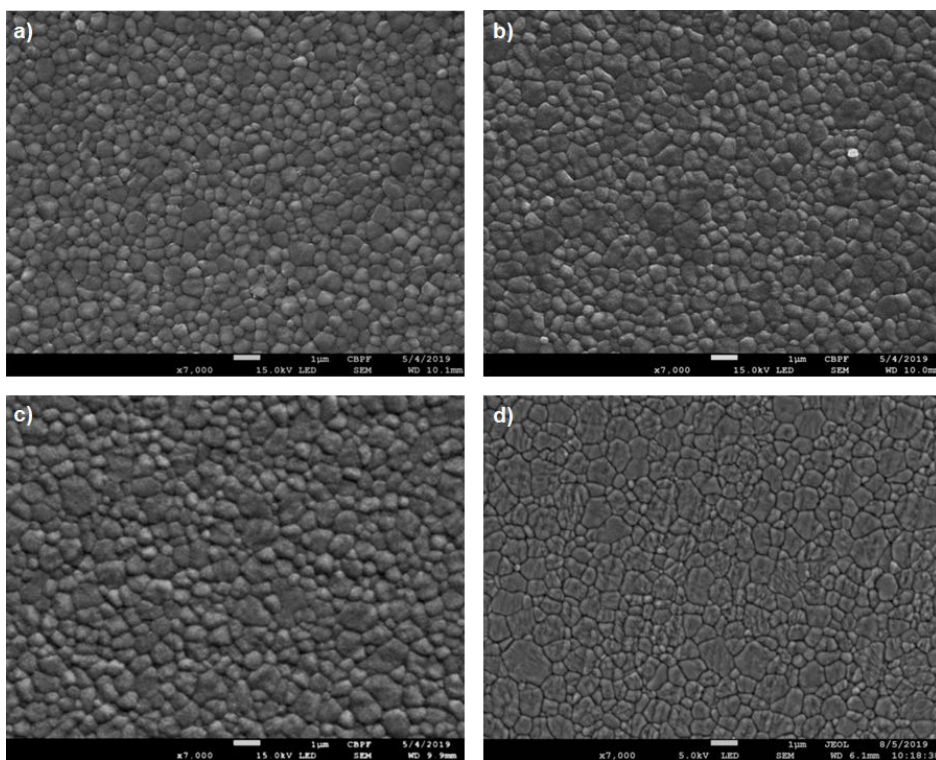
Figure 4. SEM micrographs of G3Y specimens sintered at: a) 1475 °C, b) 1500 °C, c) 1550 °C and d) 1600 °C.